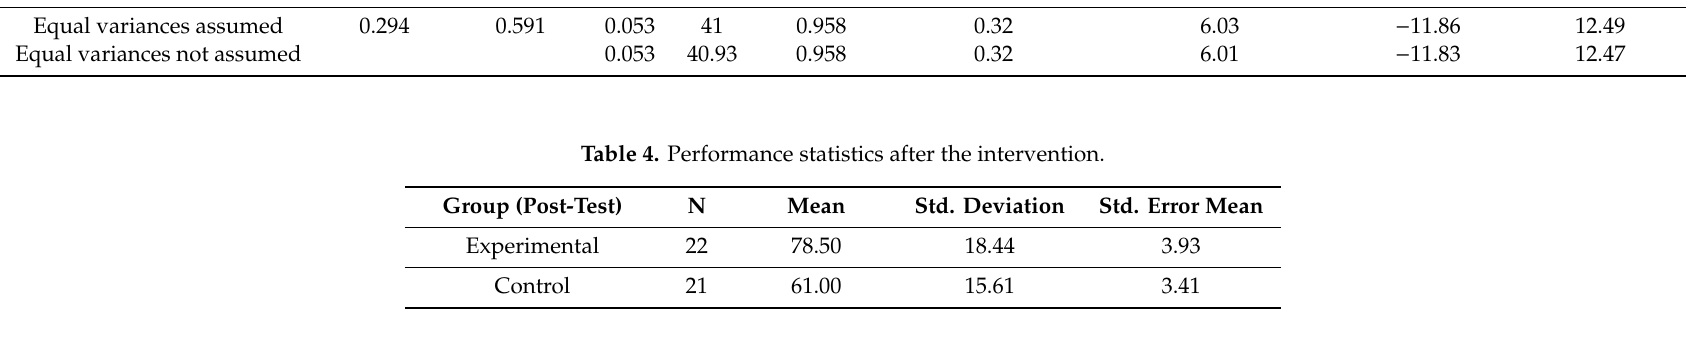
Table 5. Independent samples test